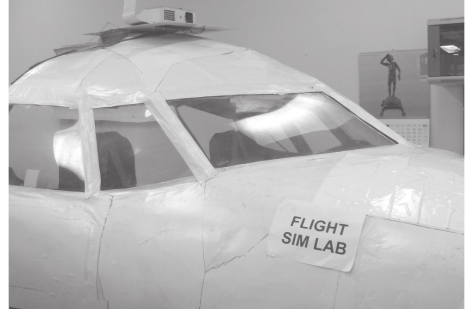
Fig. 3. The flight simulator at the